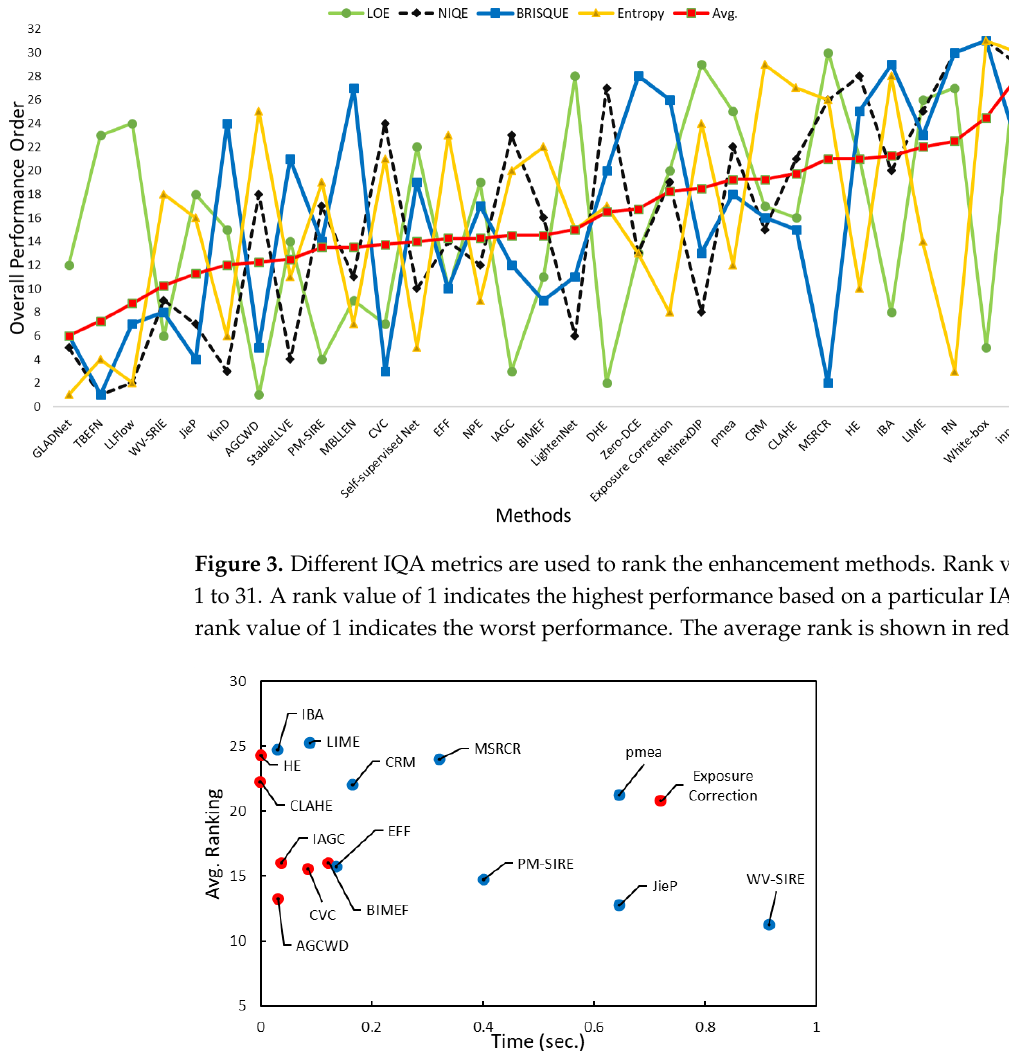
Figure 4. Avg. ranking versus Time is shown for each enhancement method. Only the methods take less than 1 s on CPU (Intel(R) Core(TM) i7-6700 CPU @ 3.40 GHz 3.41 GHz) with 16 GB RAM to process the image of size 400 × 600 × 3 is shown in the figure. Red dots represent non-Retinex methods, while blue dots represent Retinex methods.